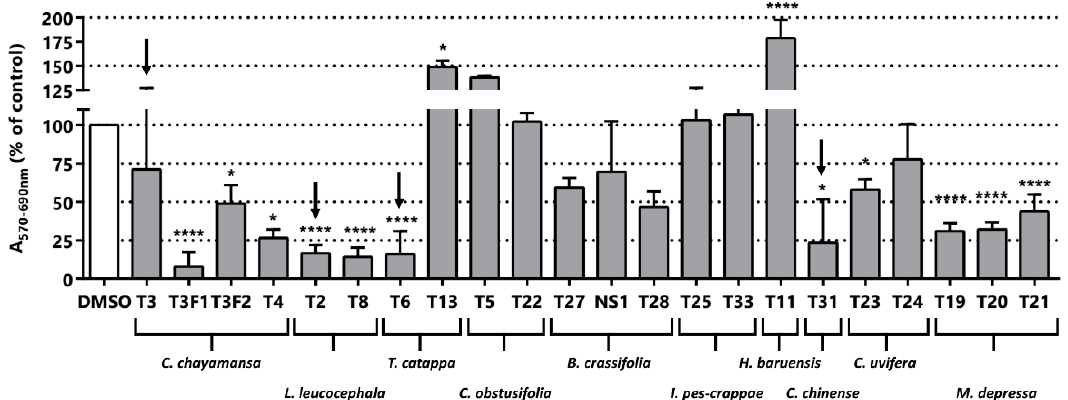
Figure 2. Phenotypic screening. Cytotoxic/anti-proliferative activity of the extracts (25 μ g/mL) in LNCaP cells. Black arrows indicate samples selected for the next step of the bioguided fractionation procedure. The nomenclature of the fractions corresponds to a code of the preparation procedure. T3F1 and T3F2 fractions of C. chayamansa are derived from the sugar extraction of the methanolic extract with ethyl acetate/water. NS1 it is a solid derived from the T27 fraction isolated by filtration during the evaporation process. Statistical significance is * p < 0.05; **** p <